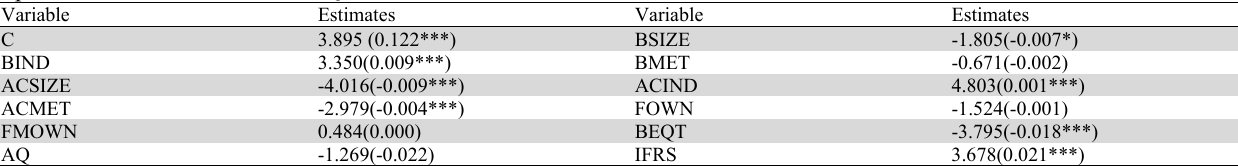
Impact of CG mechanisms on